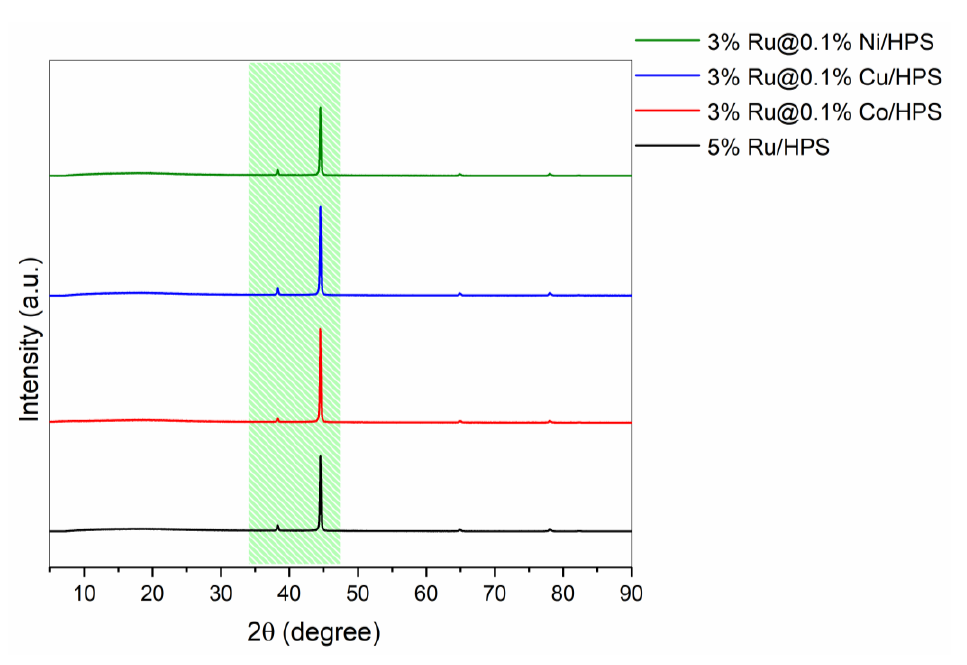
Figure 3. Ruthenium and doped ruthenium/HPS catalysts XRD compilation.